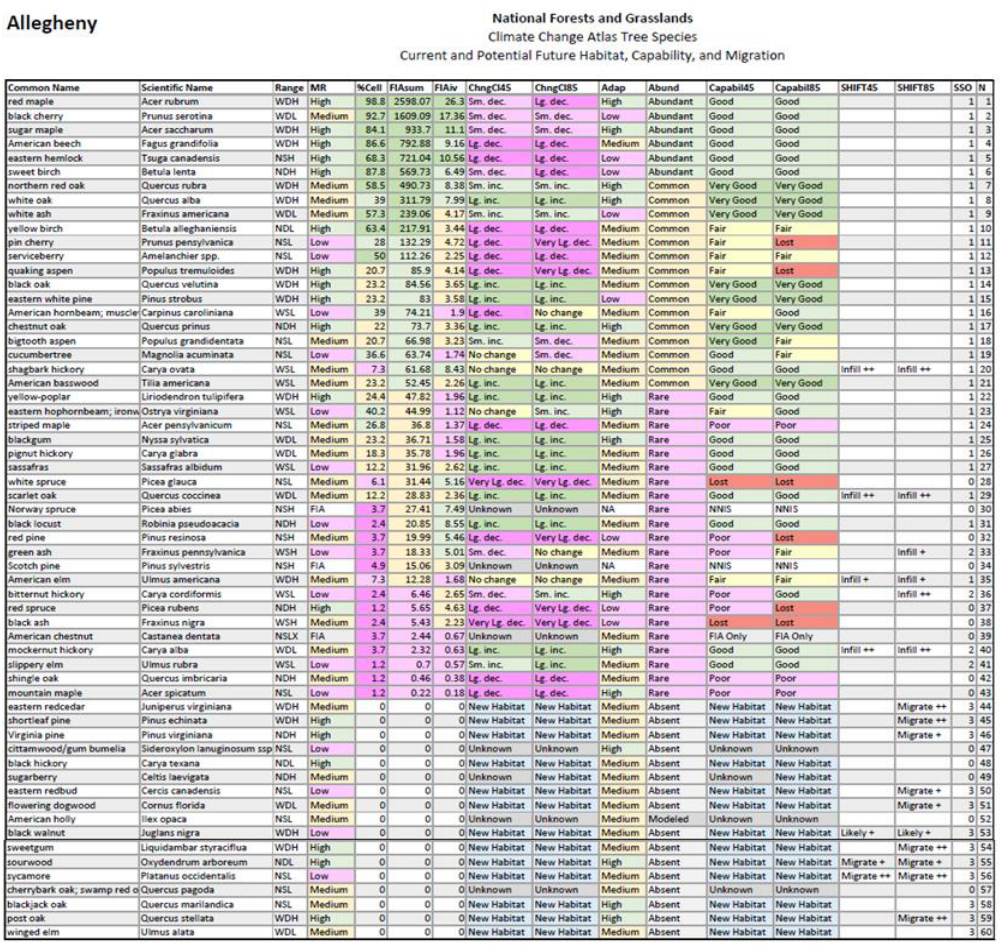
Figure 4. HQ and CL output table for the Allegheny National Forest, Pennsylvania, sorted in decreasing order of current species abundance (FIAsum). Range indicates whether species is wide or narrow (W/N) in distribution, dense or sparse (D/S) in frequency of presence within FIA plots, and high or low (H/L) in importance value when it is found. MR refers to model reliability (see [21] for explanation). %Cell refers to the percentage of DISTRIB-II cells with the species present. FIAiv is the average importance value for the species when present on FIA plots. ChngCl45 or 85 presents the change classes (increase, decrease, or no change) of habitat suitability by 2100, according to RCP 4.5 (low emissions) or 8.5 (high emissions). Adapt is a class of adaptability of the species according to the ModFacs. Abund is an abundance class based on FIAsum. Capabil45 or 85 is the capability of the species to cope with the climates of RCP 4.5 or 8.5 at 2100, based on abundance, change classes, and adaptability. SHIFT45 and 85 show two classes of Infill (+ or ++) to indicate these species are currently found rarely in the NF and likely to expand in the next 100 years, while Migrate (+ or ++) indicate that the species did not occur on FIA plots, but SHIFT (RCP 4.5 or 8.5) did indicate potential for colonization in the NF within 100 years. We also show two classes of Likely (+ or ++) to show, because of signals within SHIFT outputs, that the species is likely present in the unit even though it was not found on the FIA plots within the unit. SSO is species selection option to assist in decisions regarding promoting the species, where 1 indicates the species is currently present and has at least a fair capability to cope, 2 indicates the species is rare or close to the NF boundary and has a good chance of spreading into the NF, 3 indicates the species is not recorded in FIA plots but does have some chance of getting colonized within 100 years, and 0 indicates further evaluation may be required. Finally, the N column simply is a counter. The table is explained fully in Supplementary File 3— Explanation of species tables.